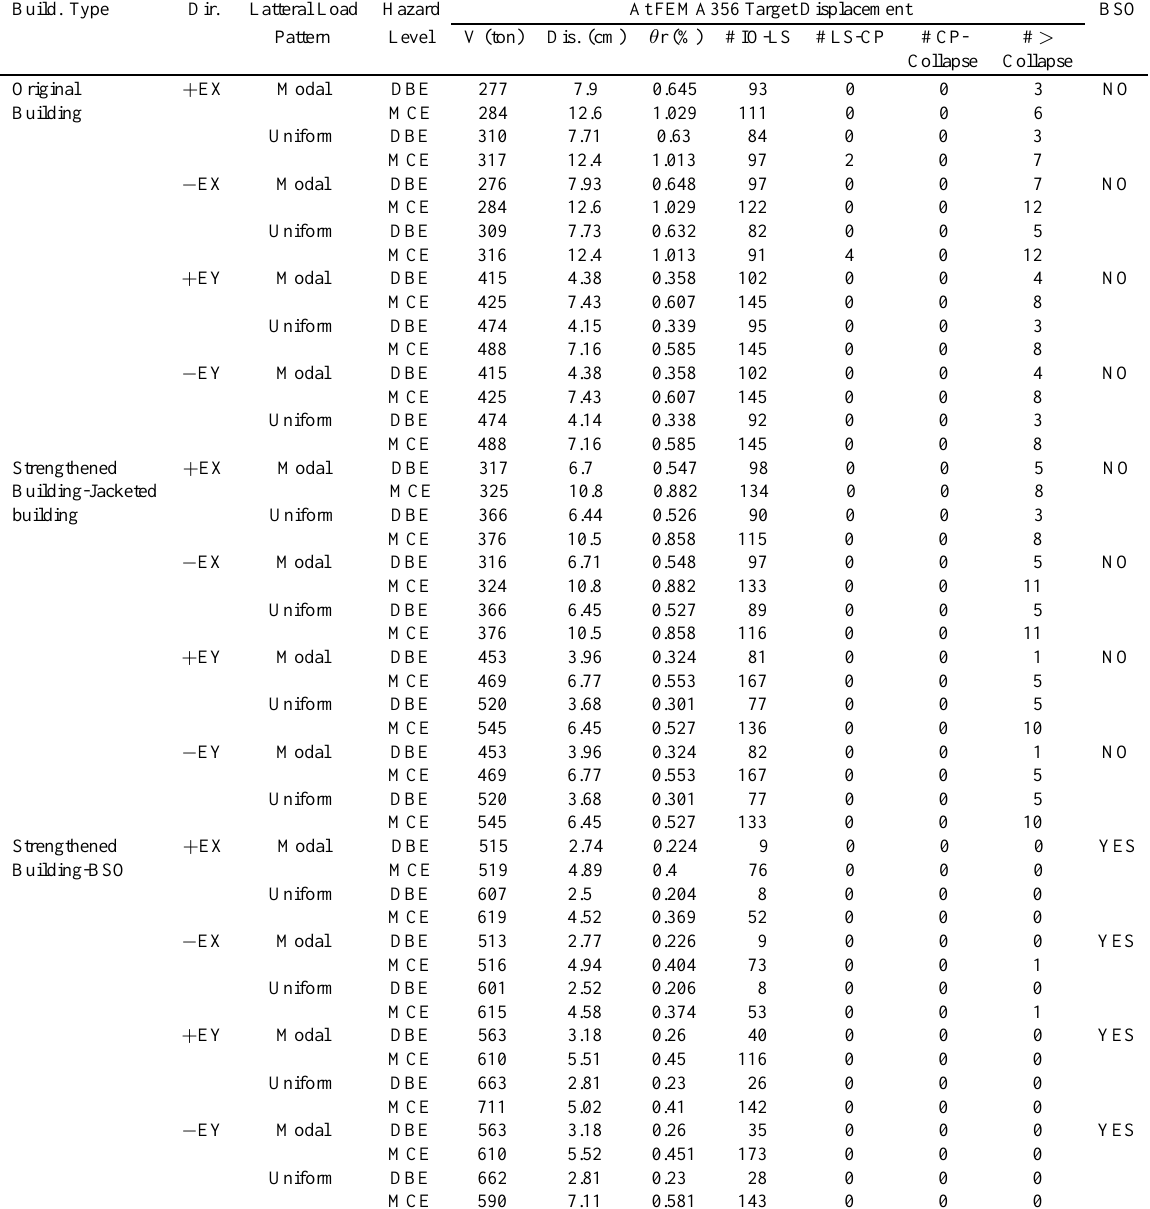
Table 3 Comparison of existing and strengthened buildings at FEMA 356 target displacement